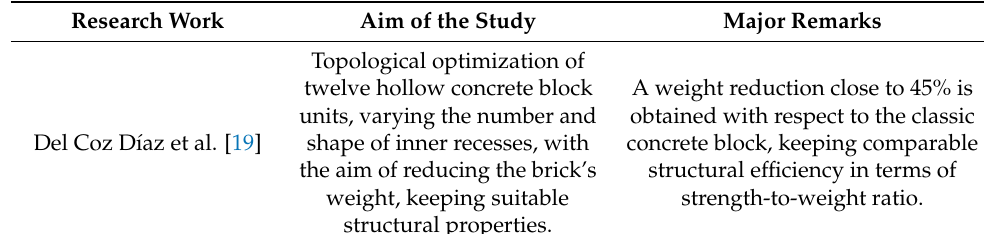
Table 1. Design and shape optimization of hollow concrete bricks: A brief